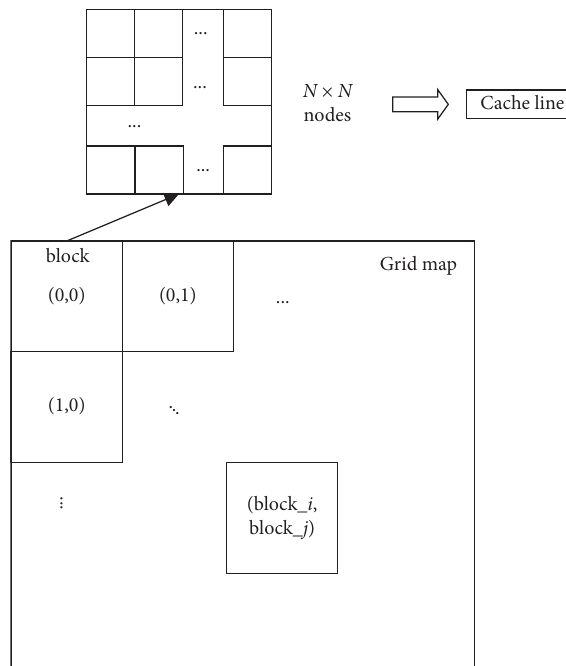
Figure 4: Block-based arrangement for nodes in cache. Each block contains N × N